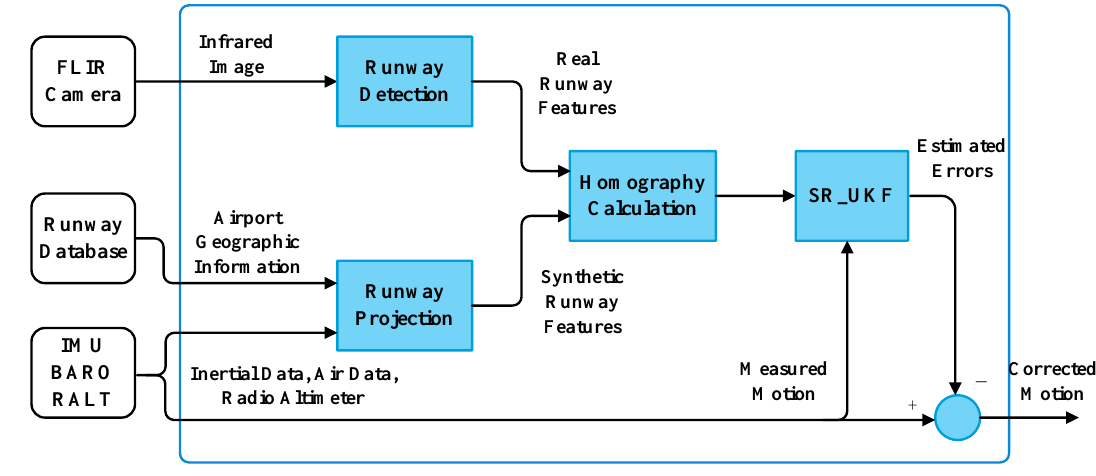
Figure 2. Framework of the proposed landing navigation: the blue box is the core part of the proposed approach